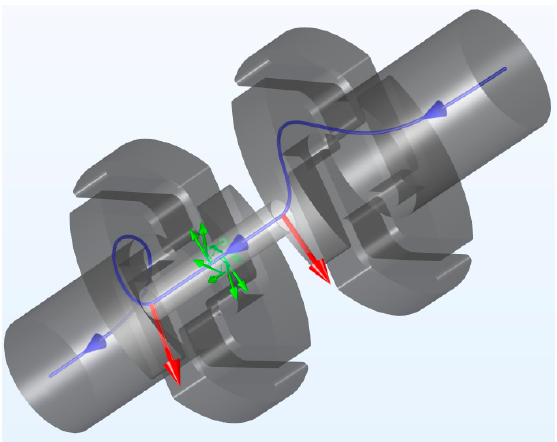
Figure 3. Schematic representation of RMF contact working principle. Blue tracer shows the current flow, green arrows represent the direction of magnetic flux density, and red arrows show the direction of resulting Lorentz force.